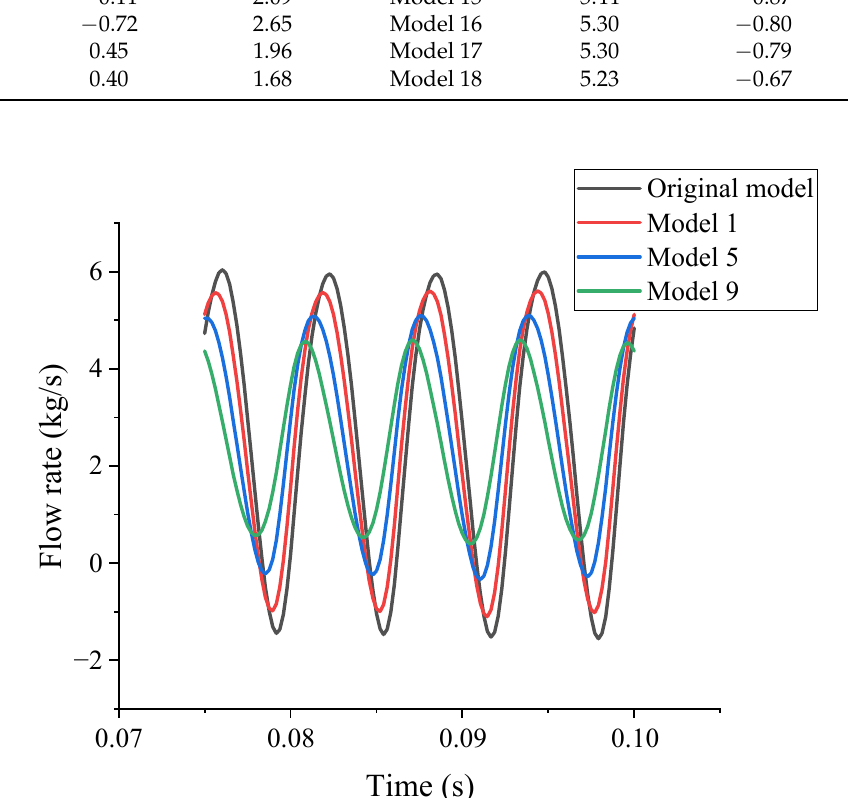
Figure 11. Outlet flow fluctuation. Figure 12a presents the flow inhomogeneity and average flow variation at the outlet of the nine groups of the arc-shaped reflux groove optimization model. Also, Figure 12b shows the flow inhomogeneity and average flow variation at the outlet of the nine groups of the rectangular reflux groove optimization model. The solid line denotes the decreasing proportion of the unevenness of the outlet flow, while the dashed line represents the decreasing proportion of the average outlet flow.